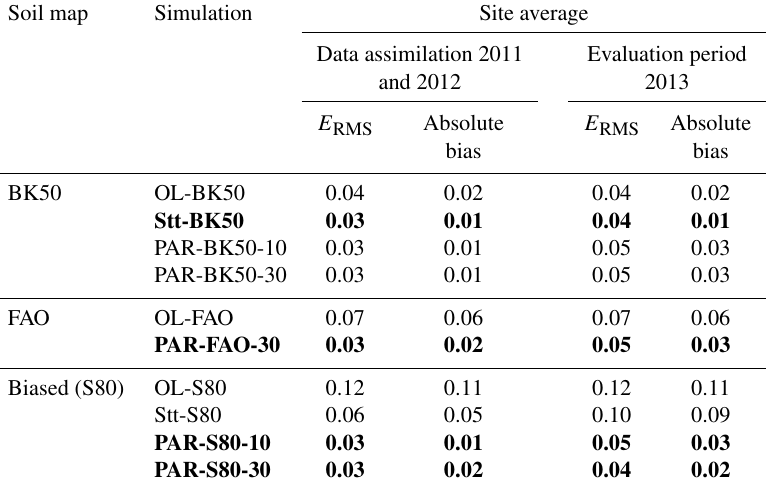
Table 3. Root mean square error ( E RMS , cm 3 cm − 3 ) and mean absolute bias (cm 3 cm − 3 ) for open loop simulations (OL- ∗ ), data assimilation with state updates (Stt- ∗ ) and joint state–parameter updates (PAR- ∗ ) for both the assimilation period (2011 and 2012) and the evaluation period (2013). Error and bias was averaged over all sites with observations. Site-specific errors and biases are provided in Appendix A1 to A4. The best cases are marked in